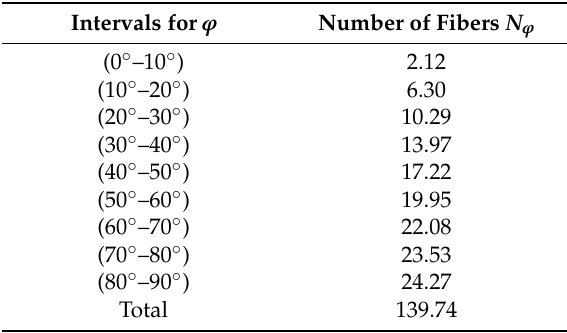
Table 1. Number of fibers traversing the crack